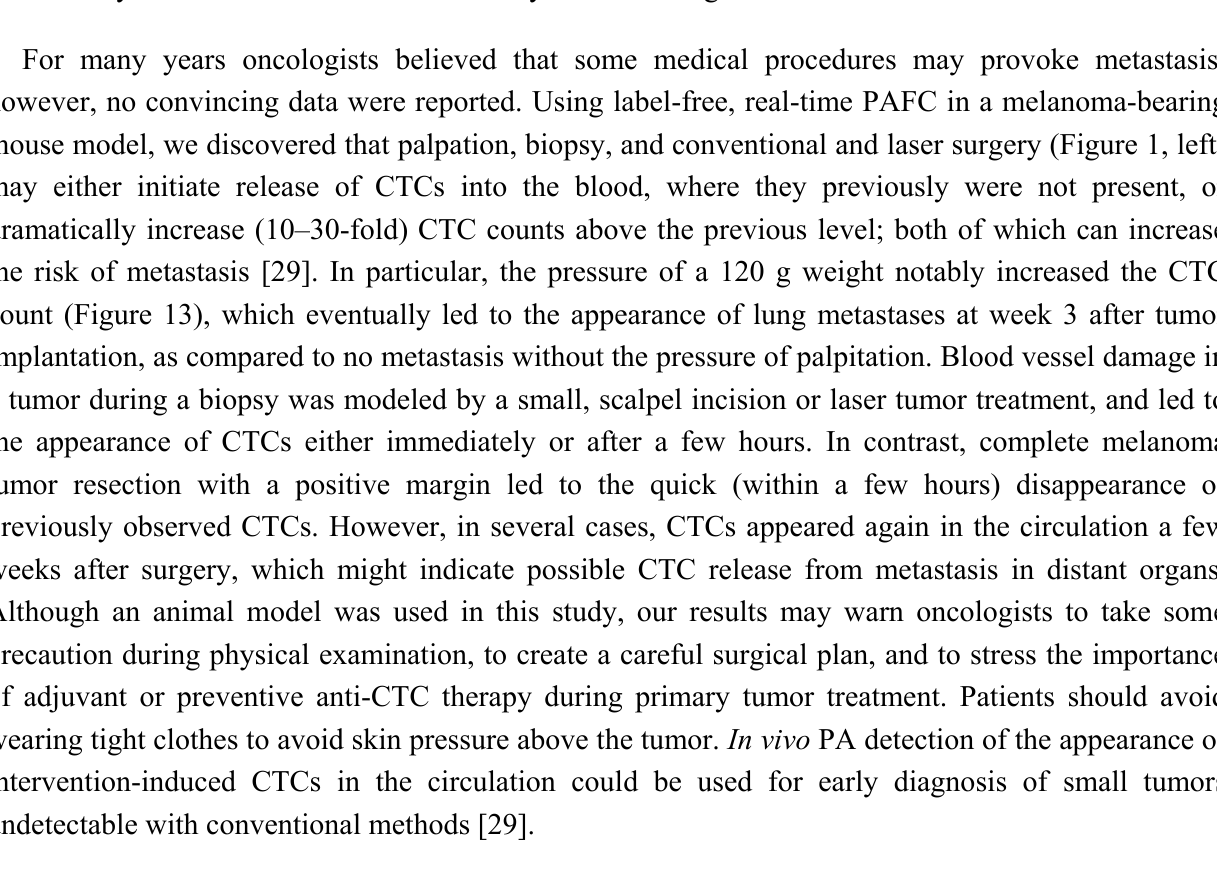
Figure 13. Typical PA signal trace produced by melanoma CTCs (B16F10-GFP) in microvessels of the mouse ear before, during, and after application of 120 g pressure on an ~5 mm-diameter skin tumor